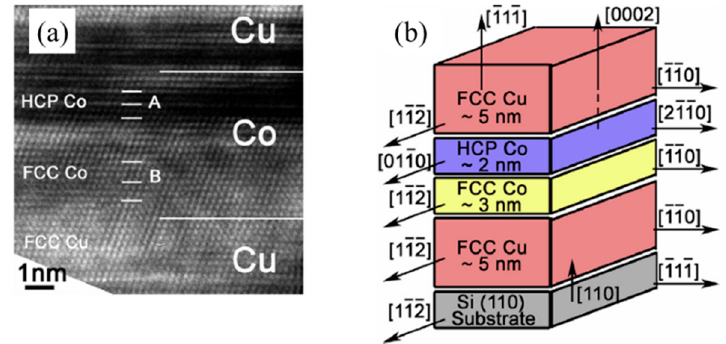
Figure 3. ( a ) HRTEM image of Cu/Co NMMFs with h = 5 nm reveals the coexistence of hcp and fcc Co. ( b ) The corresponding orientation relationship [20].